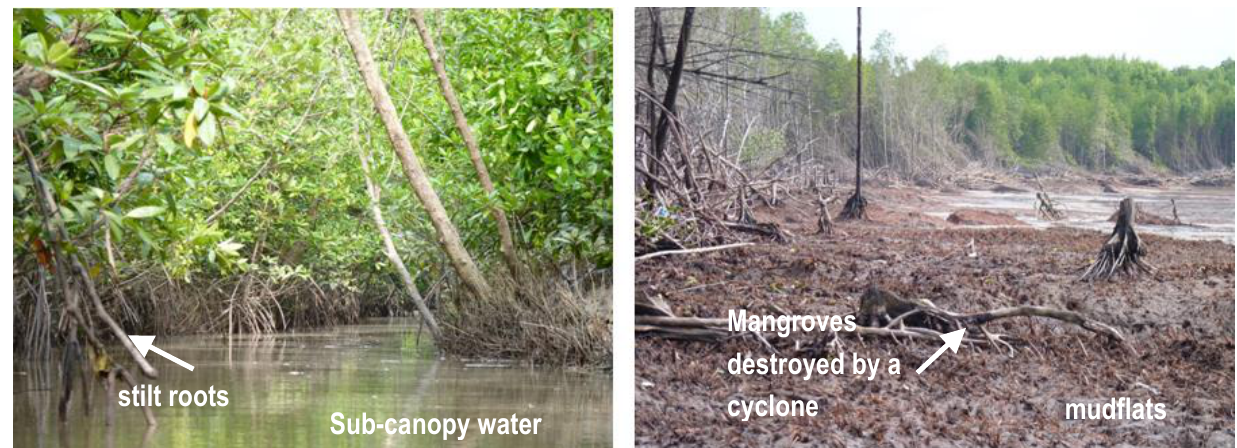
Figure 2. Mangroves in Ca Mau Province, Vietnam, January